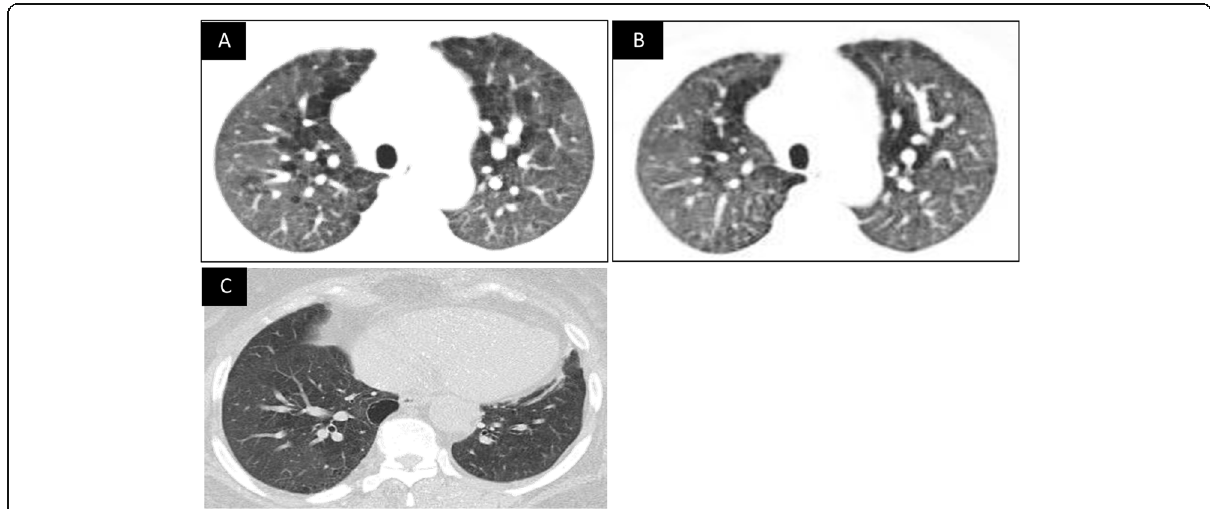
Fig. 2 a An inspiratory axial MDCT image showing ground-glass and honeycombing appearance. b , c Expiratory axial MDCT images showing areas of air trapping as well as subpleural cyst